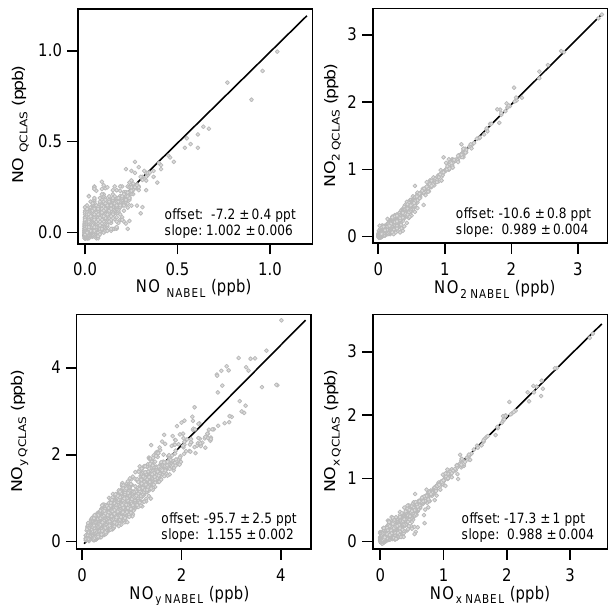
Fig. 6. Correlation plots of the QCLAS and CraNOx data. The results of the regression analysis are given as slope and intercept values.